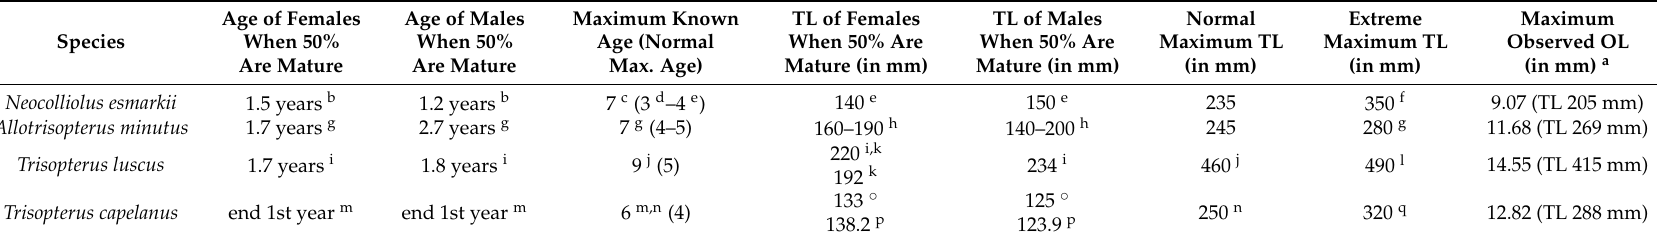
Table 1. Synopsis of ages and sizes of recent trisopterine Gadidae.